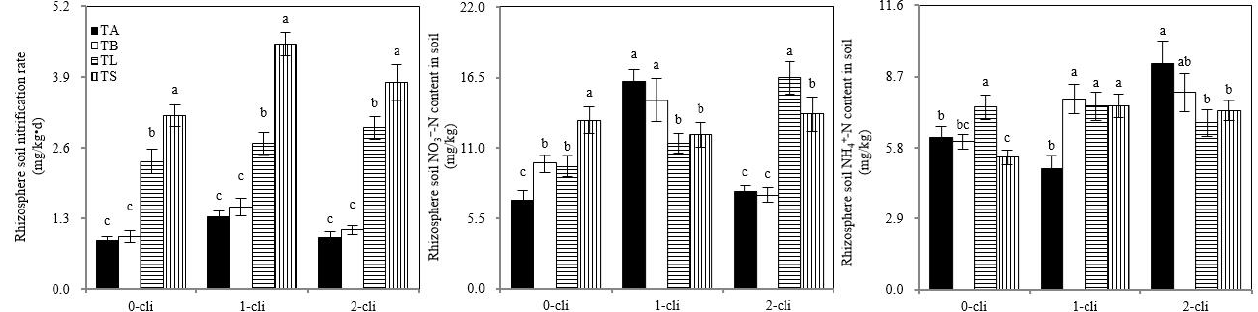
Figure 7. Rhizosphere soil nitrification rate, rhizosphere soil ammonium and nitrate nitrogen contents of Italian ryegrass in the different treatments in the experiment. TA, TB, TS, TL indicate treatments of regrowth with liquid medium without AOB added relatively long before defoliation, regrowth with liquid medium without AOB added shortly before defoliation, regrowth with S2_8_1 strain inoculated relatively long before defoliation, and regrowth with S2_8_1 strain inoculated shortly before defoliation, respectively. “0-cli”, “1-cli” and “2-cli” mean, respectively, days 0, 7 and 14 after defoliation. The values are the mean ± standard error (n = 3). The different letters in each row indicate significant differences ( p < 0.05).